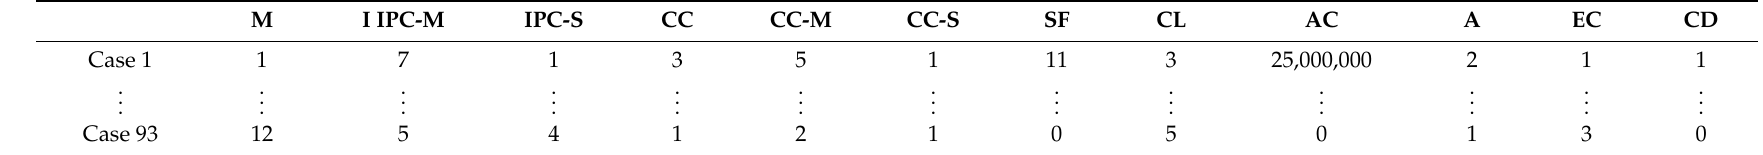
Table 3. Input data example of patent infringement cases